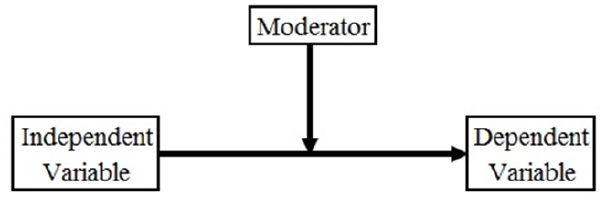
Figure 5. Moderating variable (Reprinted from Ref. [51]).